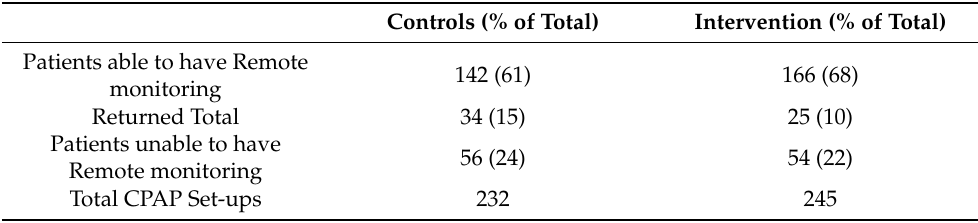
Controls (% of Total)